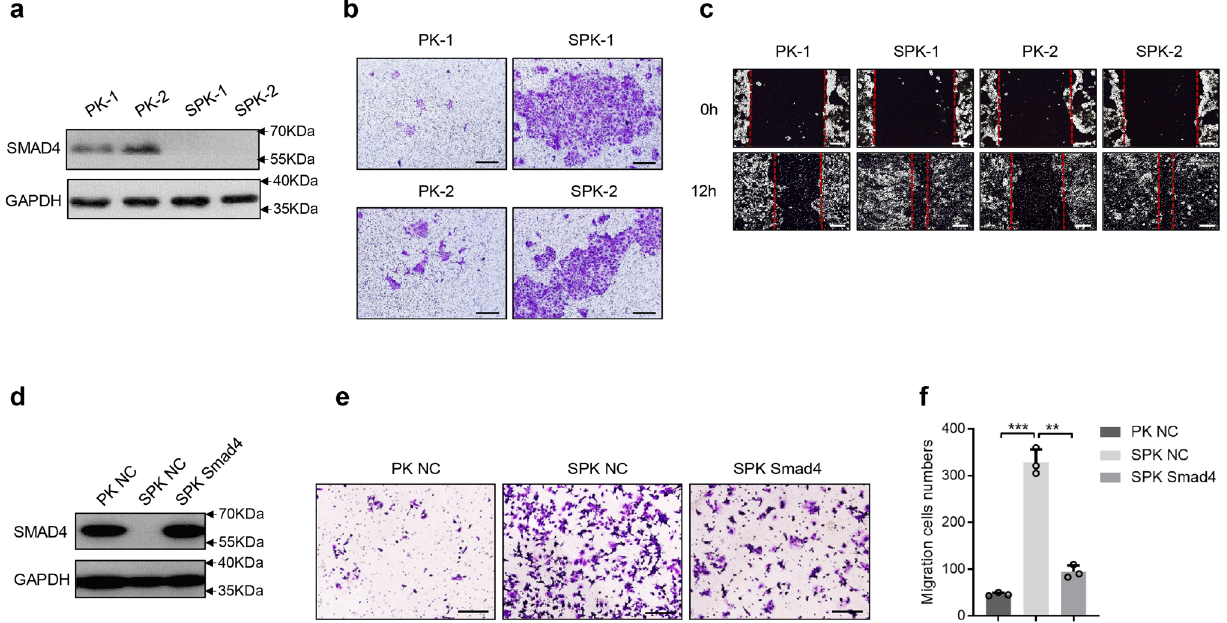
Fig. 2 Abrogation of Smad4 promotes lung cancer cell migration and invasion. a Primary lung cancer cells were isolated from lung tumors of PK and SPK mice and immortalized. The protein levels of Smad4 were examined in PK and SPK cells, and the experiment was repeated three times independently with similar results. Each lane represents a cell sample from an individual mouse. b The role of Smad4 in murine lung cancer cell migration/invasion was tested by Transwell assay and the experiment was repeated three times independently with similar results. Scale bar, 100 μ m. c Smad4 inhibited wound healing in cell culture. Cells were made a wound between the two red dashed lines, the area of the two dashed lines represent the level of wound healing and the cell migration activity. Wound healing percentage is the ratio of the wound healing area and the primary wound area, and the experiment was repeated three times independently with similar results. Scale bar, 100 μ m. d Transfection of Smad4 plasmid in SPK cells increased the protein level of Smad4, and the experiment was repeated three times independently with similar results. e Overexpression of Smad4 in SPK cells decreased cell migration/invasion, and the experiment was repeated three times independently with similar results. Scale bar, 100 μ m. f The number of migrated cells was quanti fi ed. Data presented are the mean ± SD from three biological replicates ( n = 3); *** p = 6.7544E-05; ** p = 0.000211036; as determined by two-tailed Student ’ s t-